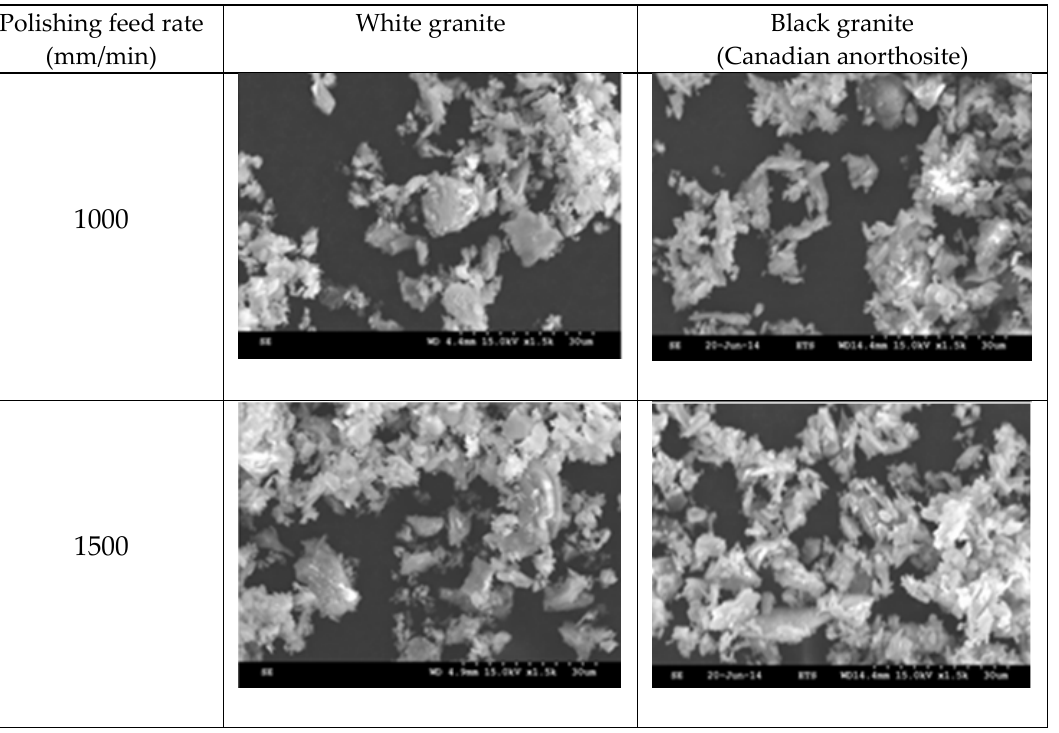
Figure 9. SEM images of particles obtained when polishing white granite and Canadian anorthosite at different feed rates (polishing speed—1000 rpm, grit size—60; pressure—0.2 bar).